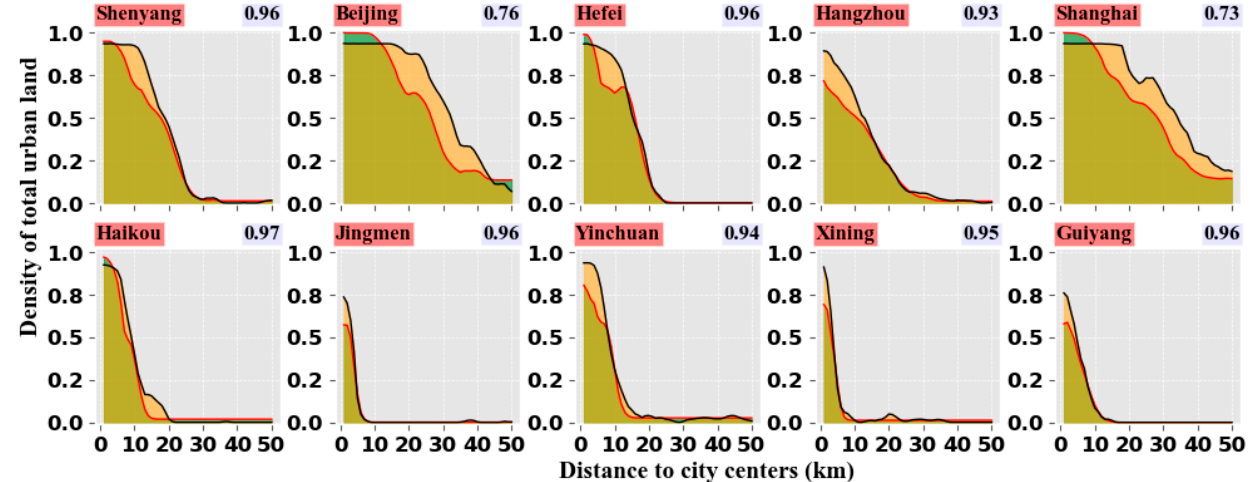
Figure 12. Observed and deduced patterns for urban-related human activities in 10 typical cities of different sizes (the value in the upper right corner indicates the R 2 ).